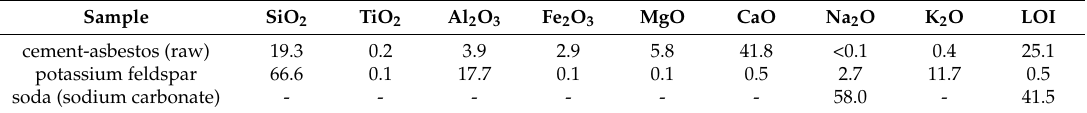
Table 1. Results of raw materials’ chemical analyses (values in wt%).